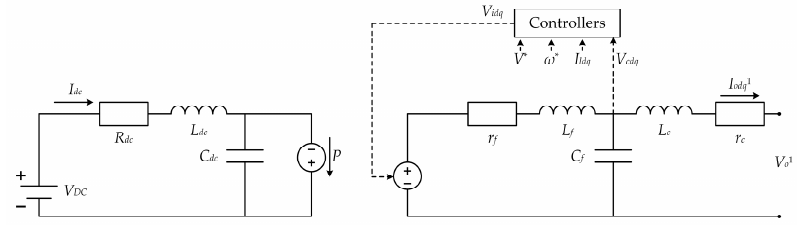
Figure 3. Model of the inverter in positive sequence.